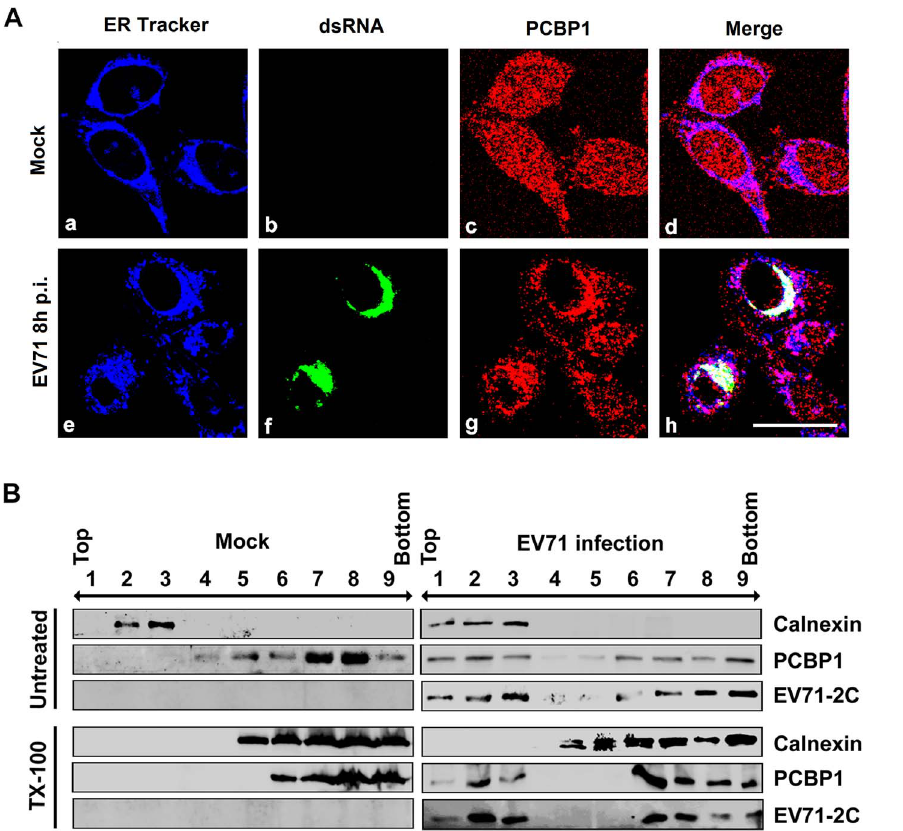
Figure 5. Localization of PCBP1 in ER-derived membrane-associated complex during EV71 replication. (A) RD cells were mock-infected or infected with EV71 at an MOI of 5 for 8 h. Cells were probed with rabbit anti-PCBP1 antibody and mouse anti-dsRNA antibody, stained with ER- Tracker, observed by confocal microscopy. PCBP1 (red), dsRNA (green), ER-Tracker (blue). Bar=20 m m. (B) Membrane flotation analysis of location of PCBP1. RD cells were infected with or without EV71 at an MOI of 5 for 8 h. Cell lysates from mock-infected and infected cells treated with or without Triton X-100 were separated by sucrose gradient sedimentation. Each fraction was blotted with specific antibodies to the ER marker protein (calnexin, CNX), PCBP1, and EV71 2C, respectively. Fractions 1 to 3 represent the membrane fraction. Fractions 4 to 9 represent the cytosolic fraction.